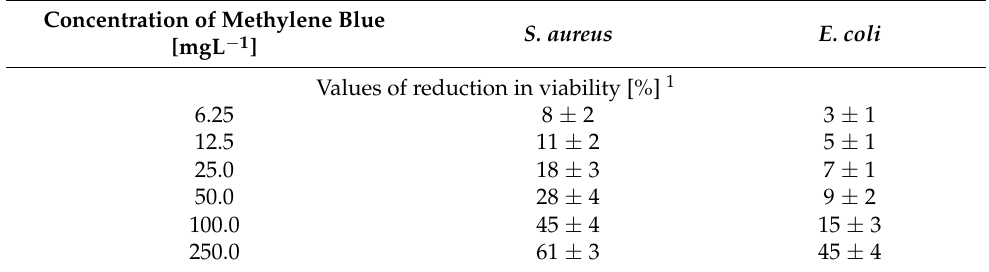
Table 1. Bactericidal efficacy of methylene blue (MB) against Staphylococcus aureus and Escherichia coli under dark conditions.